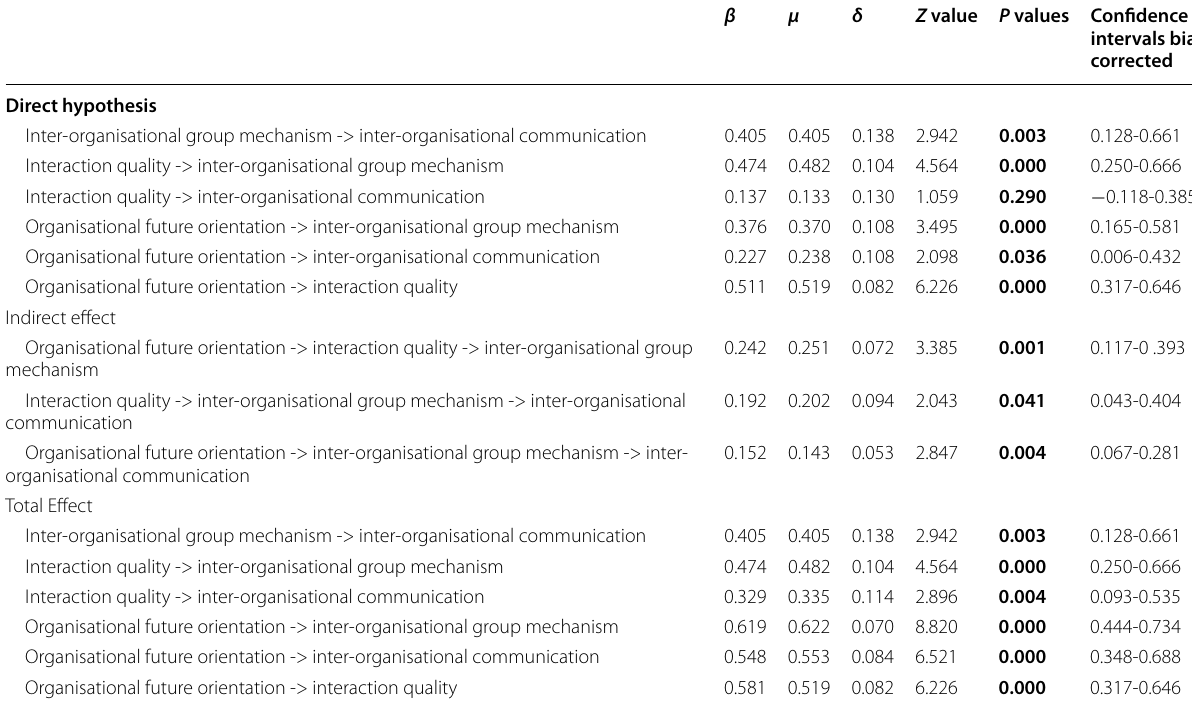
Table 11 Mediation test